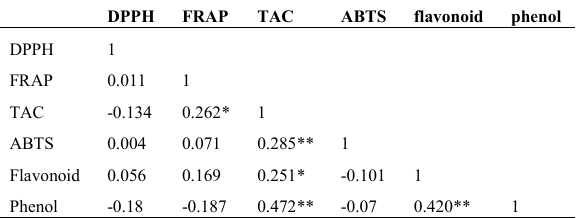
correlation was significant at the 0.01